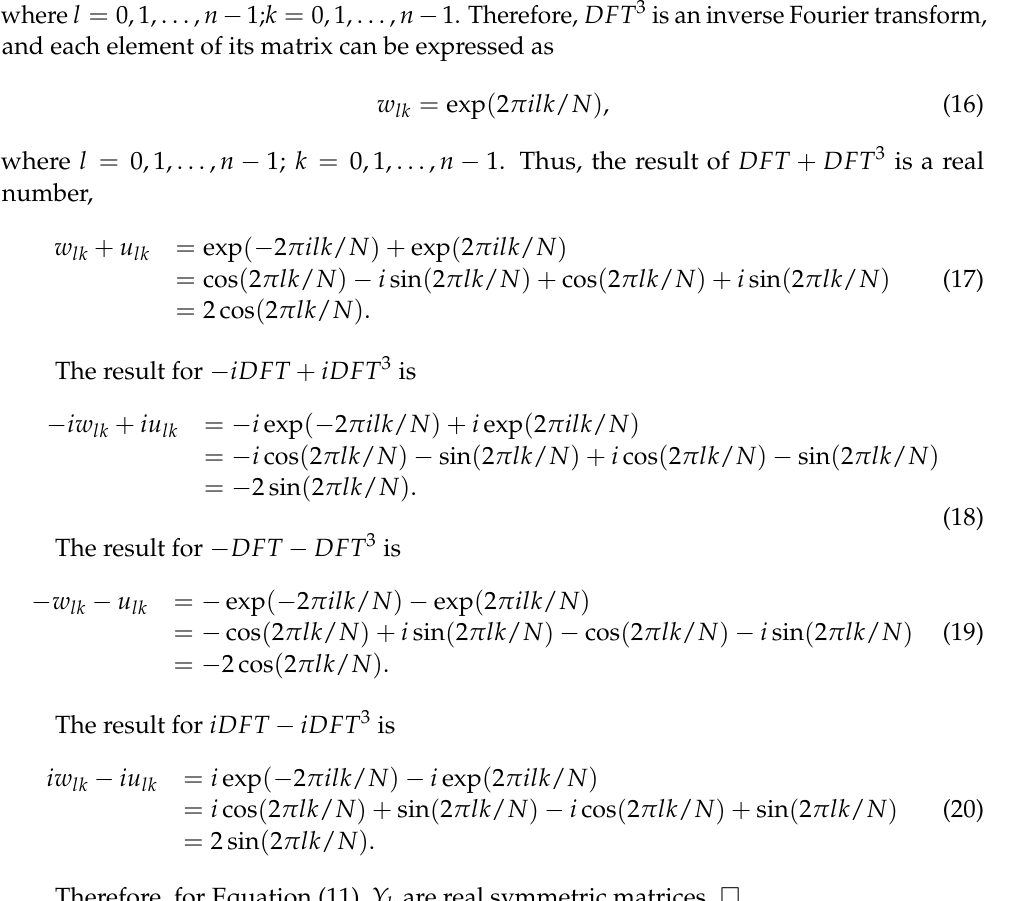
where is an inverse Fourier transform, and each element of its matrix can be expressed as